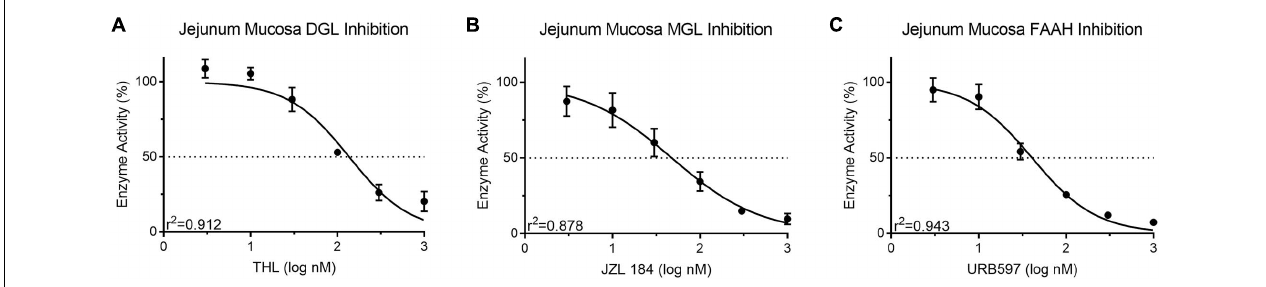
FIGURE 4 | Activity of the MAG biosynthetic enzyme, DGL, in mouse small-intestinal epithelium was dose-dependently inhibited by the DGL inhibitor, THL (A) IC 50 = 136.3 nM. Activity of the MAG degradative enzyme, MGL, in small-intestinal epithelium was dose-dependently inhibited by the MGL inhibitor, JZL 184 (B) IC 50 = 47.62 nM. Activity of the FAE degradative enzyme, FAAH, in small-intestinal epithelium was inhibited by the FAAH inhibitor, URB597 (C) IC 50 = 40.76 nM.